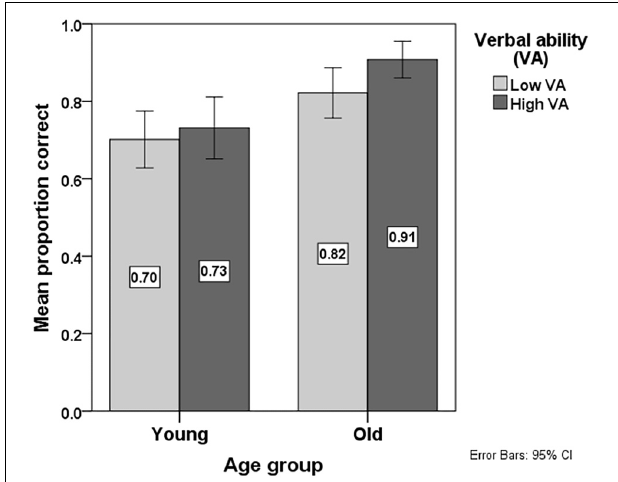
FIGURE 4 | Mean proportion of correct responses in the language comprehension task per Age group (Young: ≤ median vs. Old: > median; median = 9;3 years) and Verbal ability (VA) group (low VA: ≤ median vs. High VA: > median; median = 108.50). Background information about the four groups plotted in this figure regarding their VA, as mean scores in the PPVT: Young-Low VA group: 99.86; Young-High VA group: 121.13; Old-Low VA group: 95.96; Old-High VA group: